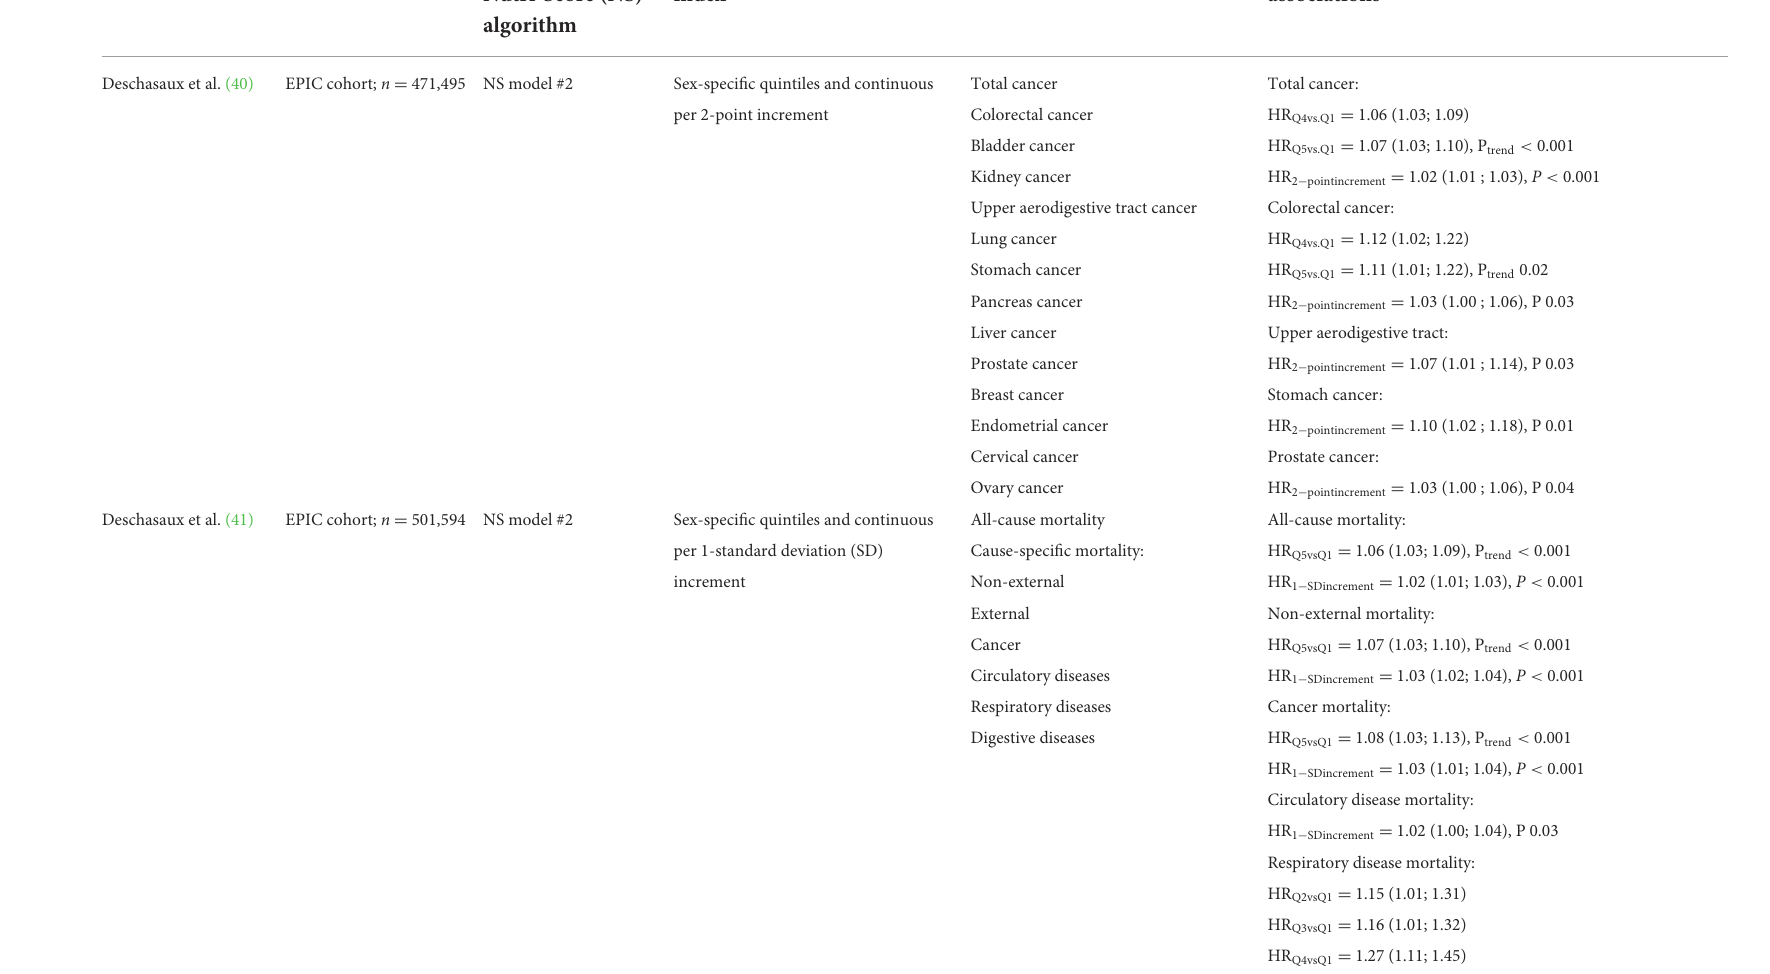
TABLE 6 Results of predictive validity studies for the Nutri-Score algorithm in the EPIC (40, 41) and SUN (42) studies: multivariable associations of the Nutri-Score dietary index with cancer risk and mortality [hazard ratios (HR) with 95% confidence